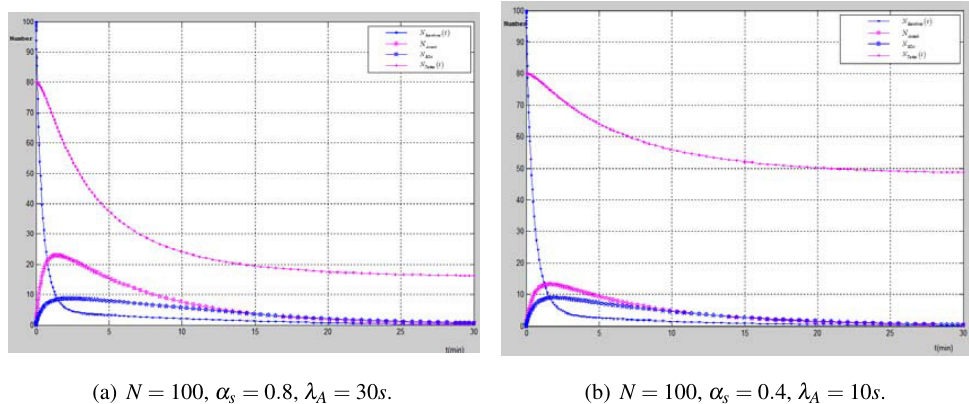
Fig. 3 The number of task state with respect to time at different attack